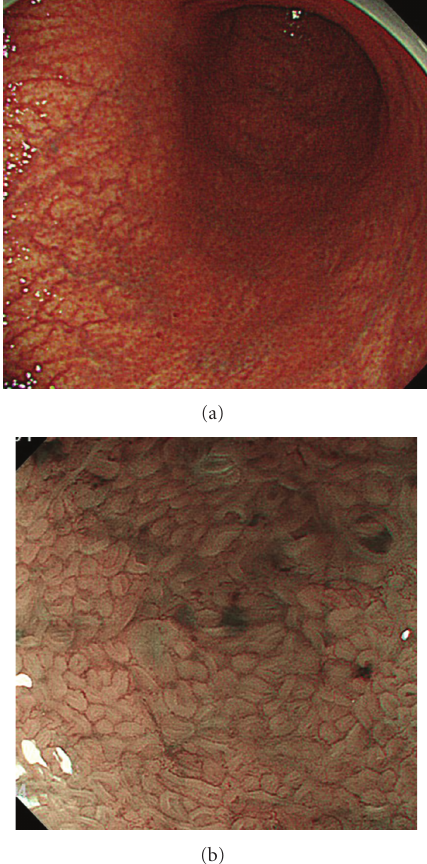
Figure 1: (a) Conventional endoscopic finding in the corpus of Case 2. (b) Magnifying endoscopic findings in the corpus of Case 2 with narrow band imaging (NBI)(full